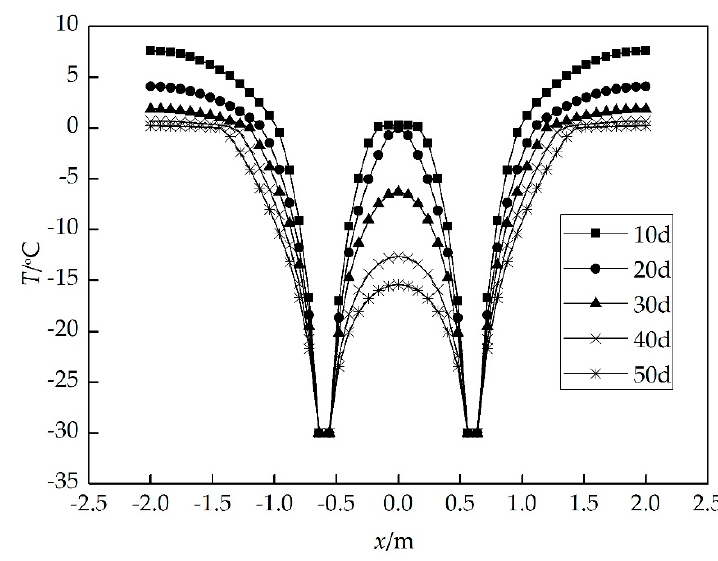
Figure 9. Temperature distribution in the main section.